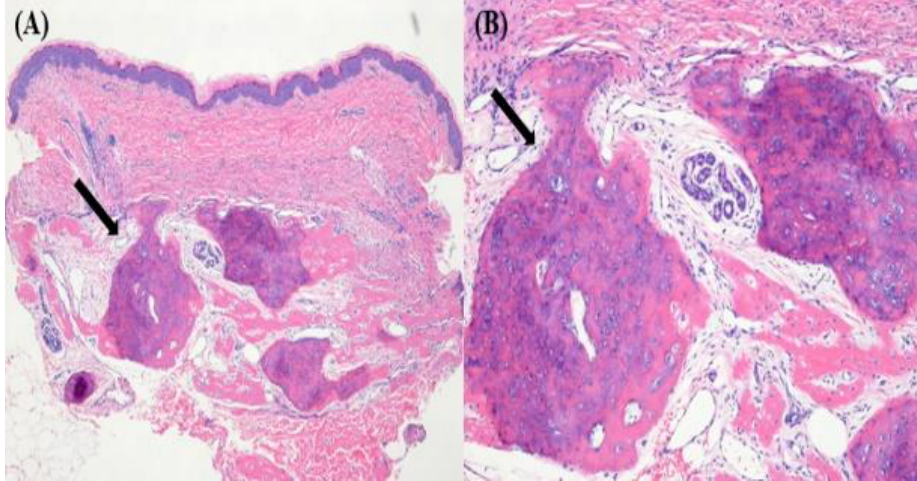
Figure 1. Histology slide showing a well-demarcated nodule, composed of mature lamellar bone within the dermis (black arrow). ( A ) 40× hematoxylin and eosin staining, ( B ) 100× hematoxylin and eosin staining.